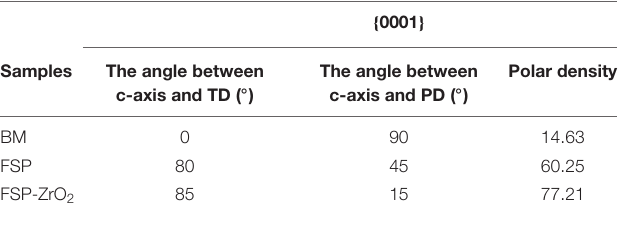
TABLE 1 | Detailed statistical results about the texture of three samples of { 0001 }